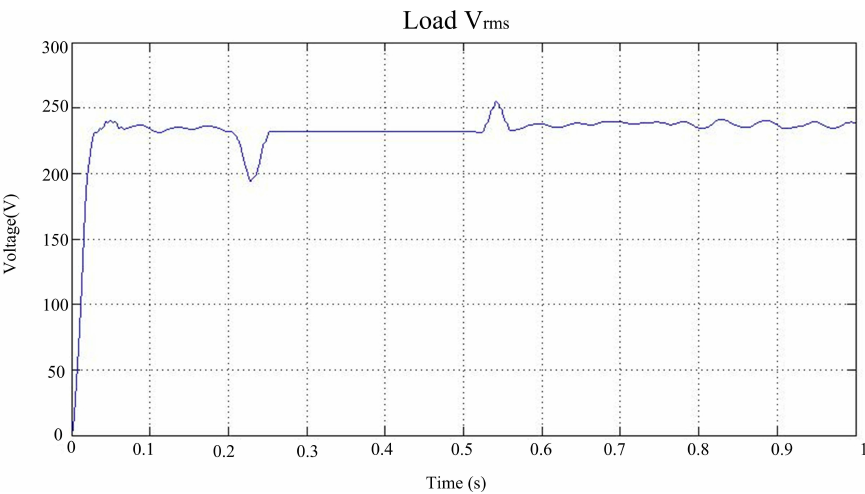
Figure 12. Voltage value of